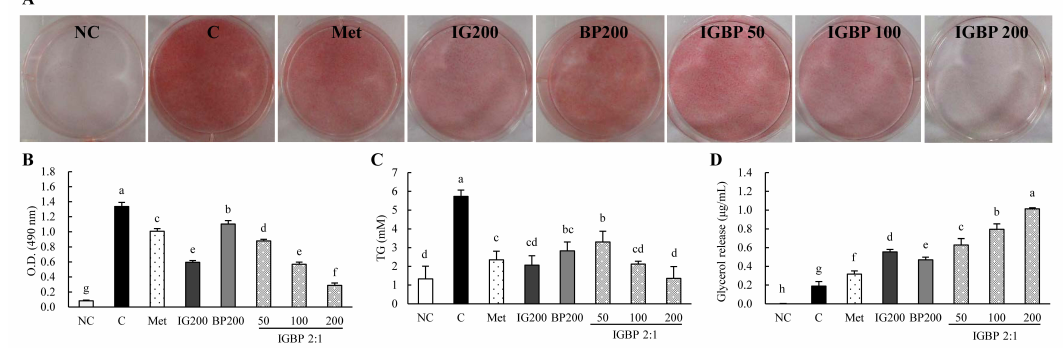
Figure 5. E ff ects of the IGBP 2:1 mixture on lipid accumulation, triglyceride (TG) levels, and glycerol release in 3T3-L1 adipocytes: ( A ) Oil Red O staining, ( B ) optical density of lipid accumulation, ( C ) TG levels, and ( D ) glycerol release. NC, normal control; C, di ff erentiated control; Met, metformin 1 mM; IG200, IG 200 µ g / mL; BP200, BP 200 µ g / mL; IGBP 2:1 (50, 100, or 200 µ g / mL). The resulting values are shown as mean ± standard deviation (SD; n = 3), and the di ff erent superscript letters (alphabet) indicate significance at p <